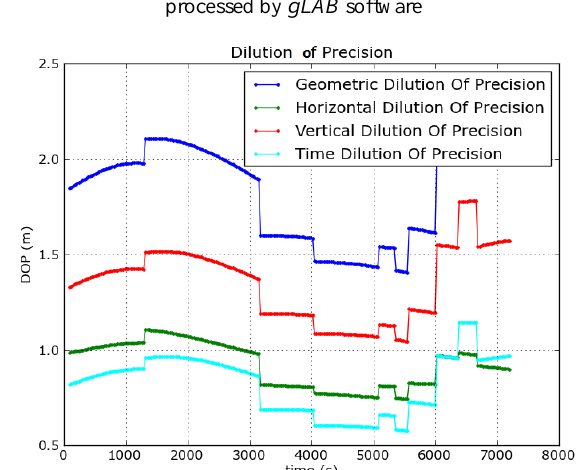
Figure 7: Code and Phase residuals vs elevation angle for combined GR